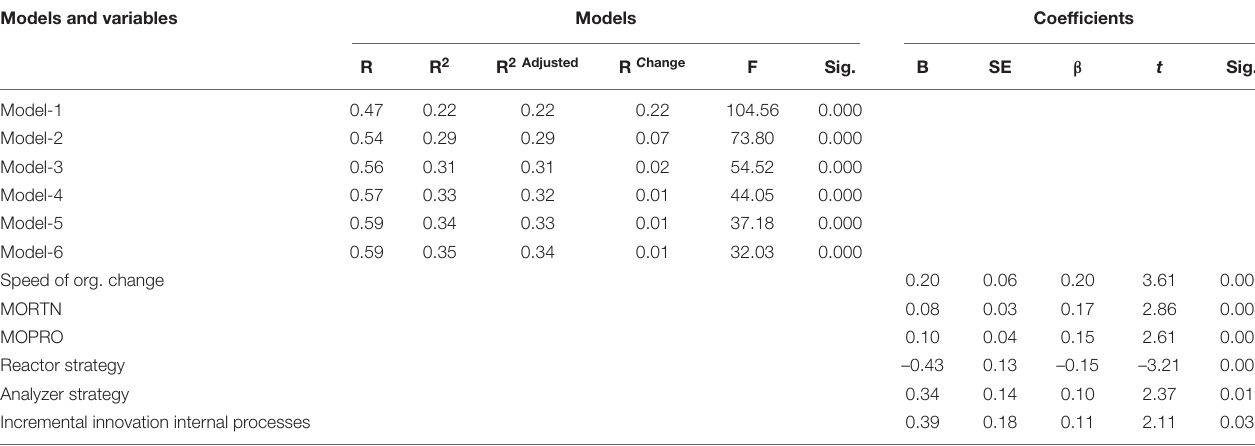
TABLE 2 | Summary of the models, predictive variables, and coefficients of regression analysis (stepwise method): clan culture (Spanish subsample n 1 = 362). Models and variables